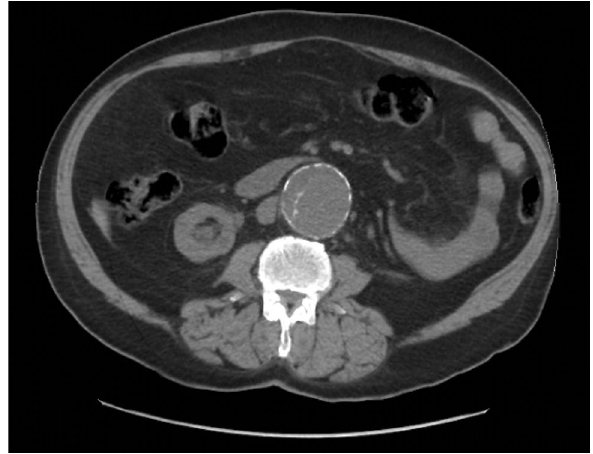
Fig. 1 CT scan from 2017 with contrast illustrated infrarenal abdomi- nal aortic aneurysm with maximum diameter of 5 cm